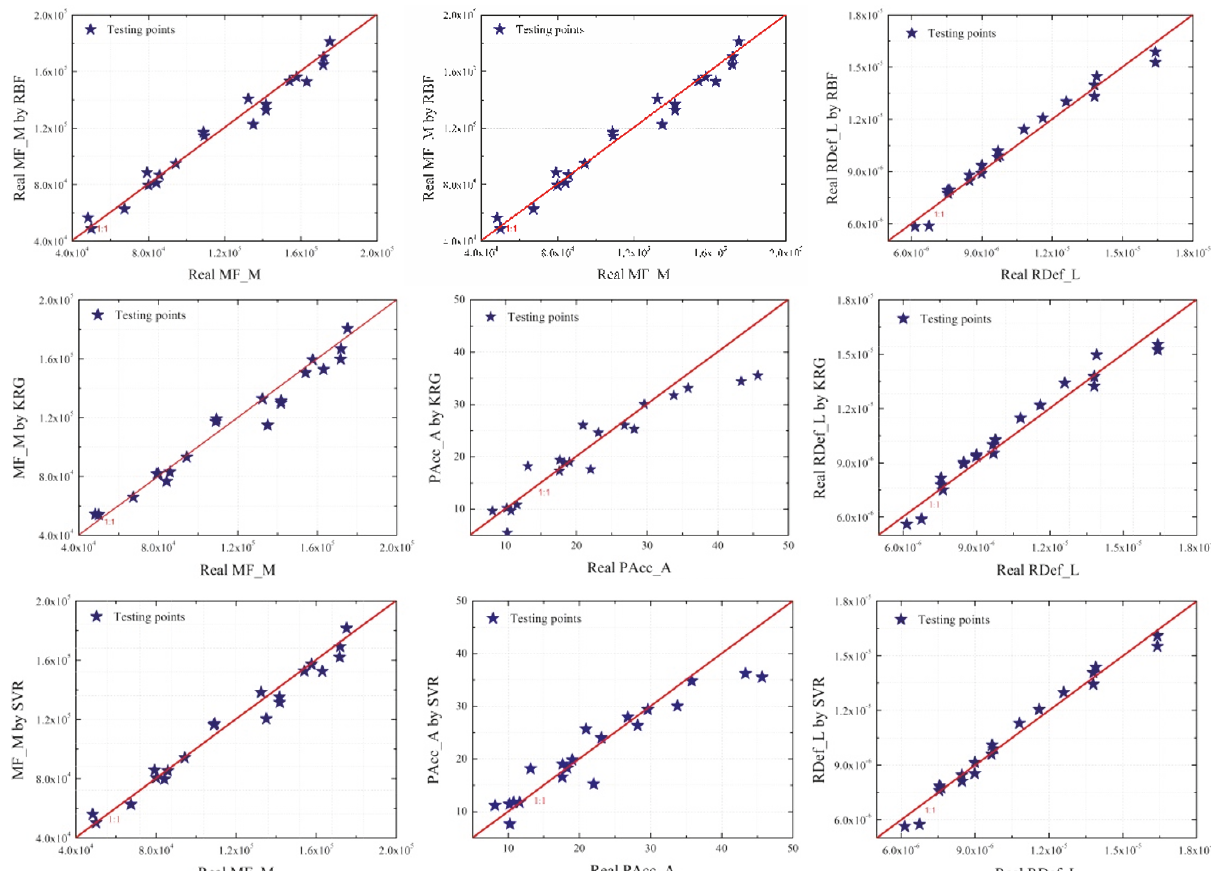
Figure 9: Comparison between real simulations and their approximations by metamodels.